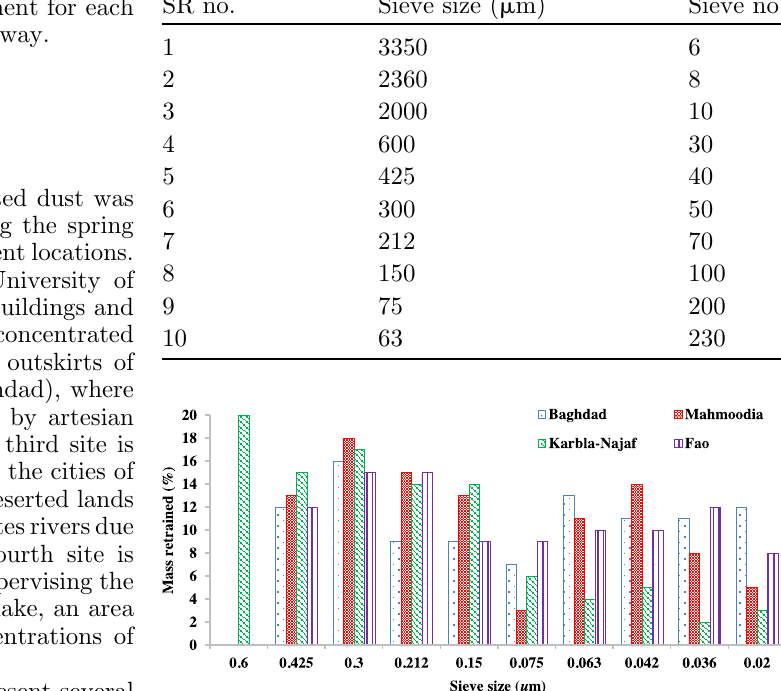
Fig. 1. Dust grain size analysis for the studied